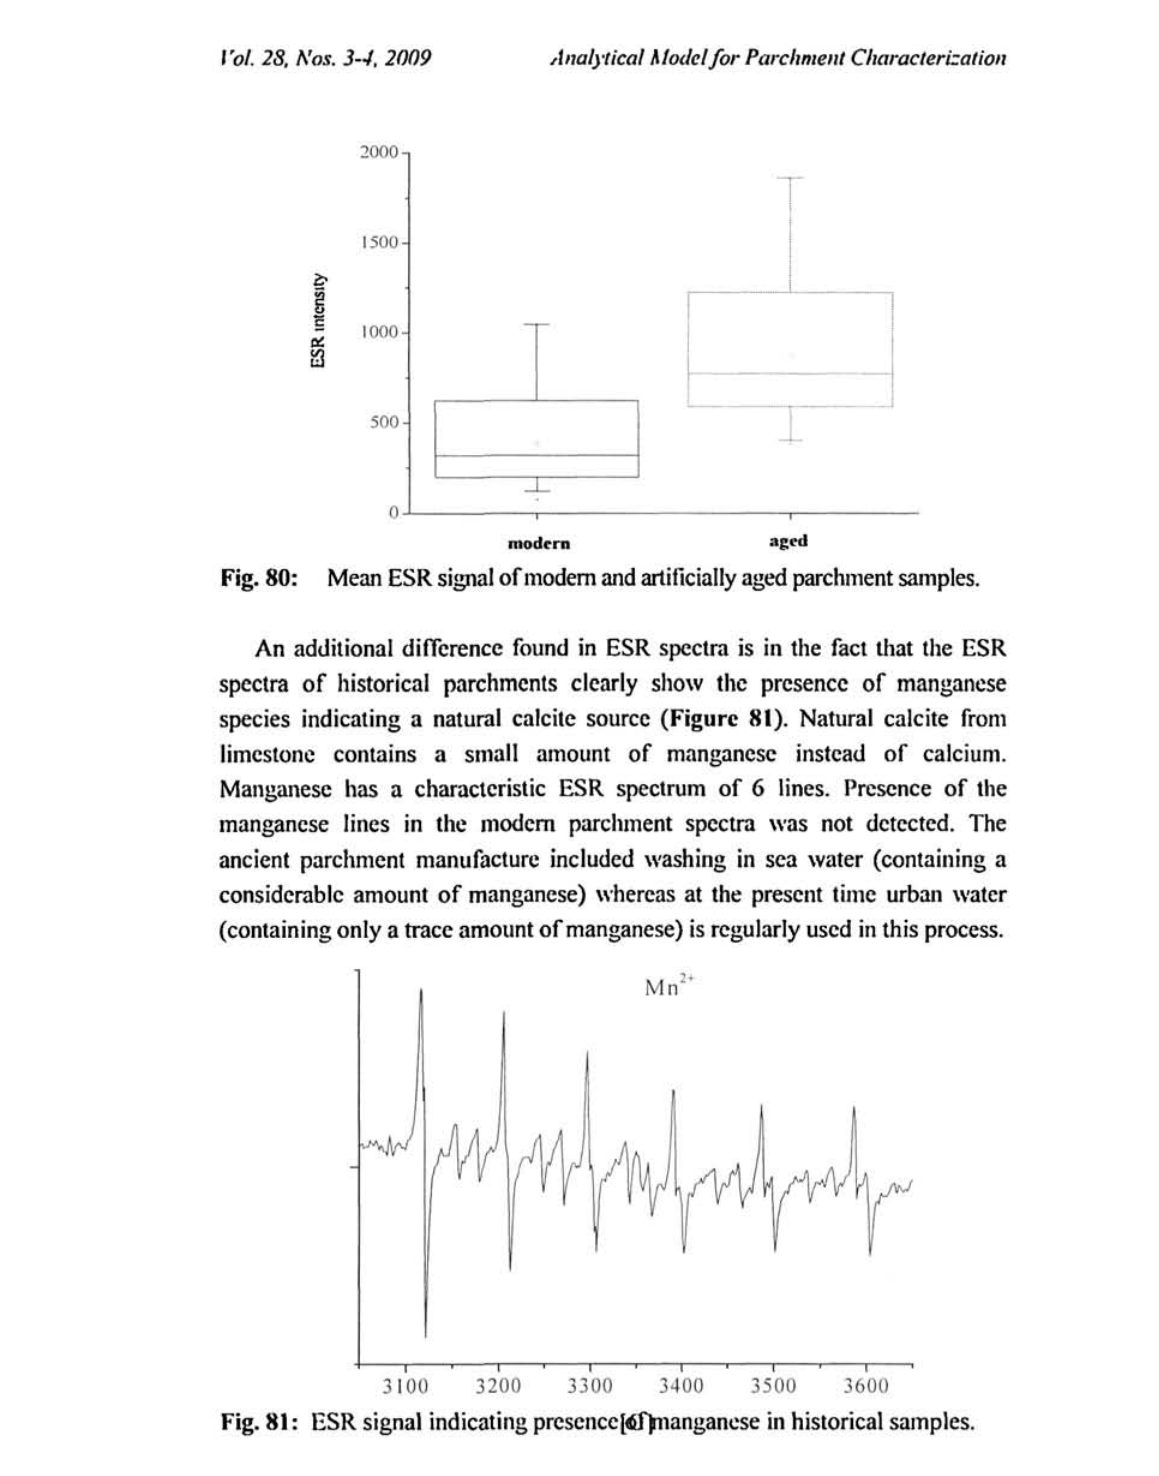
Fig. 81: ESR signal indicating presence[if^nanganese in historical samples.